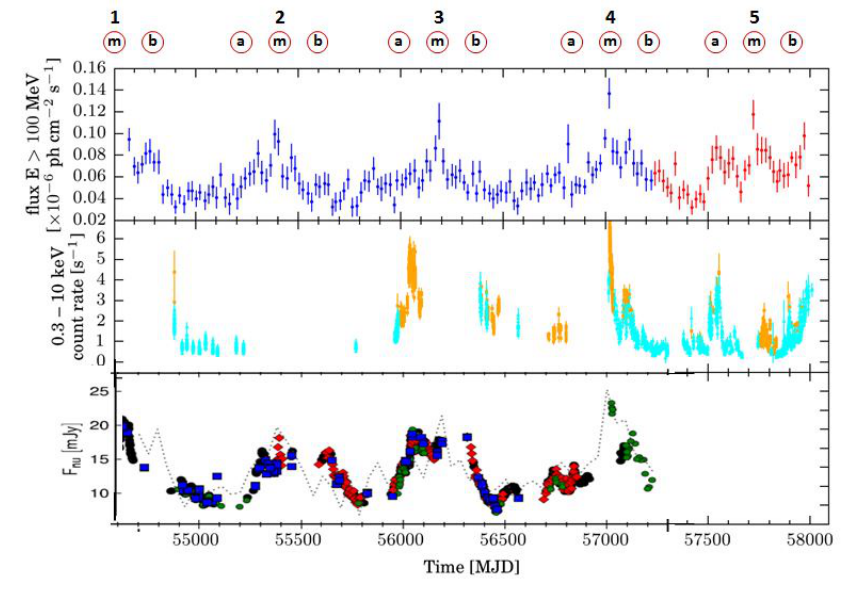
Figure 6. Light curves of PG 1553 + 113 in various bands [27]. Top panel: γ rays from Fermi LAT, with the 2016–2017 data traced in red. Middle panel: keV X-rays from Swift . Bottom panel: optical R band reported from Figure 2 of [26]. ( c (cid:13) AAS. Reproduced with